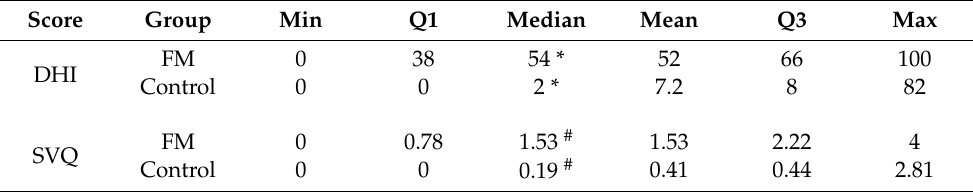
Table 4. Descriptive statistics of the Dizziness Handicap Inventory (DHI) and the Situational